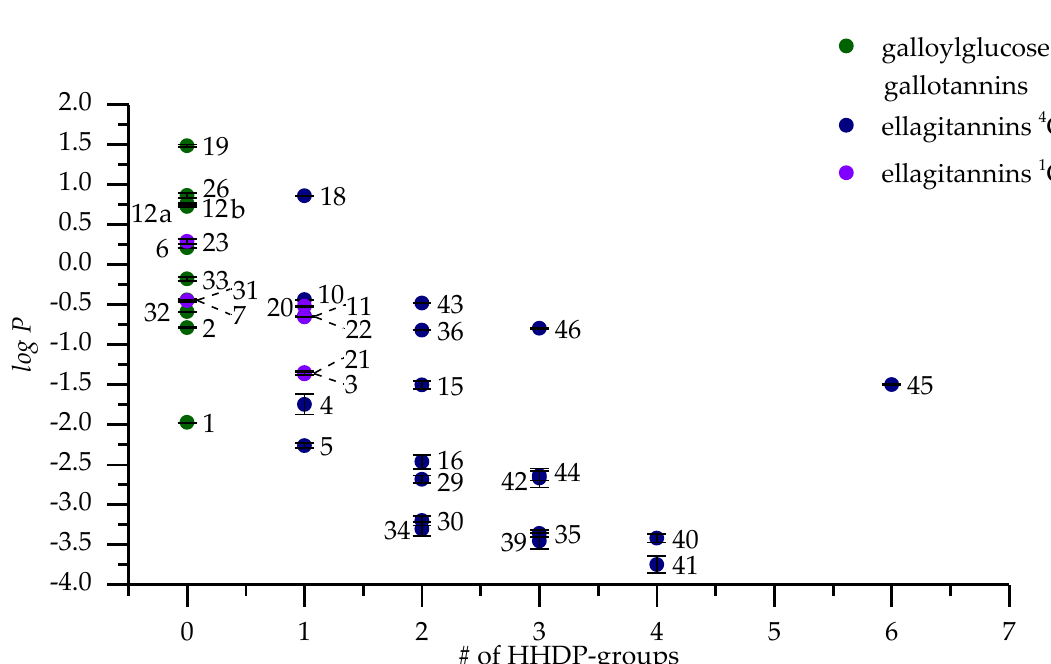
Figure 5. LogP values measured with UPLC and plotted against the number of ( S )- and ( R )-hexahydroxydiphenoyl (HHDP) groups in the structures of hydrolysable tannins also counting the HHDP groups participating in m -GOD (sanguisorboyl)- and m -DOG (valoneoyl)-type oligomeric linkages or in valoneoyl units in hippophaenins ( 29 and 30 ), castavaloninic acid ( 27 ) and vescavaloninic acid ( 28 ). Results follow the same trends seen also in Tanaka et al. [9]. The numbers refer to Figures 1 and 2 and Table A1.